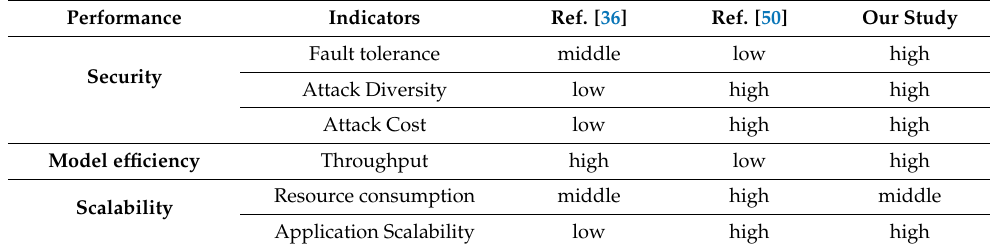
Table 8. Comparative analysis